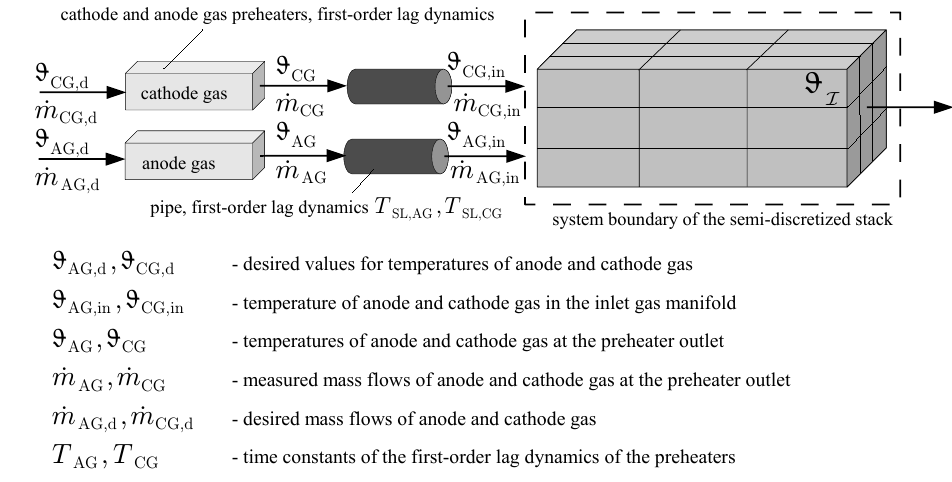
Figure 1. Semi-discretization of the fuel cell stack module with gas preheaters.